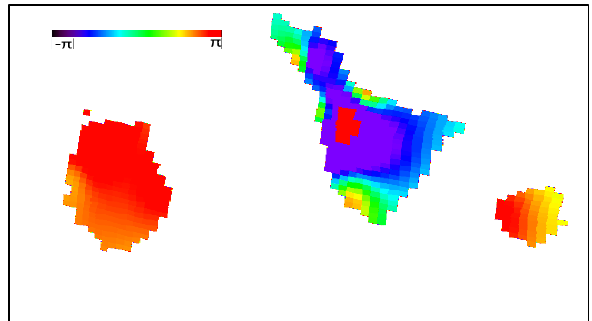
Figure 4. Simulated tropospheric phase delay from AEMET interpolated station data in RADAR geometry